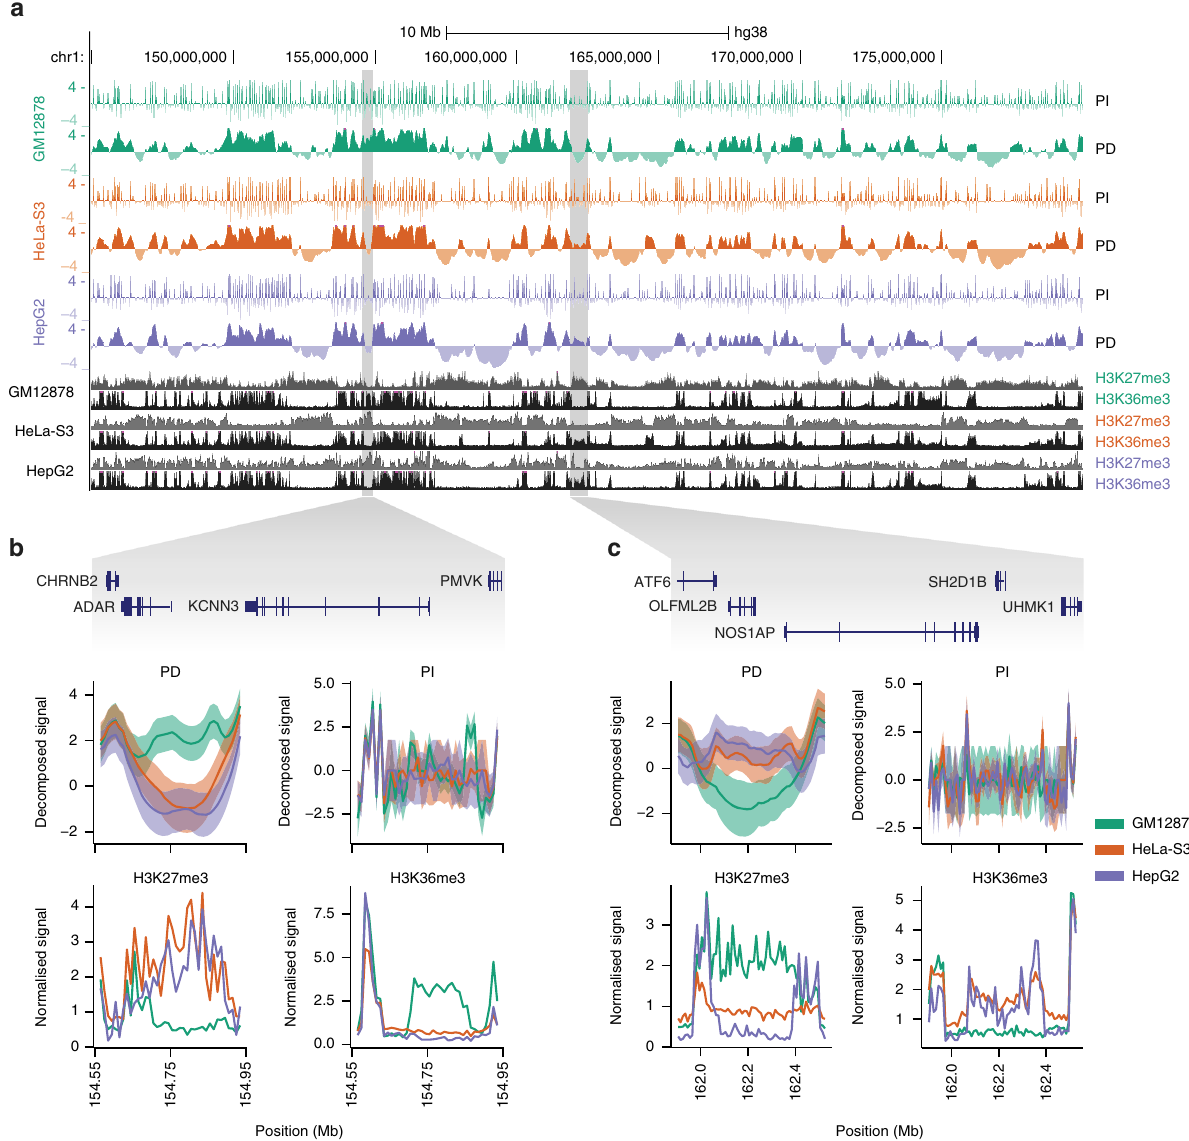
Fig. 2 Transcriptional decomposition across chromosomes. a PI and PD components (mean ± standard deviations), as well as H3K27me3 and H3K36me3 ChIP-seq data for GM12878, HeLa-S3 and HepG2 cells at locus chr1:145,000,000 – 180,000,000. b, c Loci (highlighted in a ) around KCNN3 ( b ) and NOS1AP ( c ) genes showing cell-type-speci fi c PD signals. The PD and PI signals and ChIP-seq data associated with repression (H3K27me3) and activation (H3K36me3) are and post-translational histone modi fi cations H3K4me3 and H3K27ac (binarised DNase-seq and ChIP-seq data 37 in each